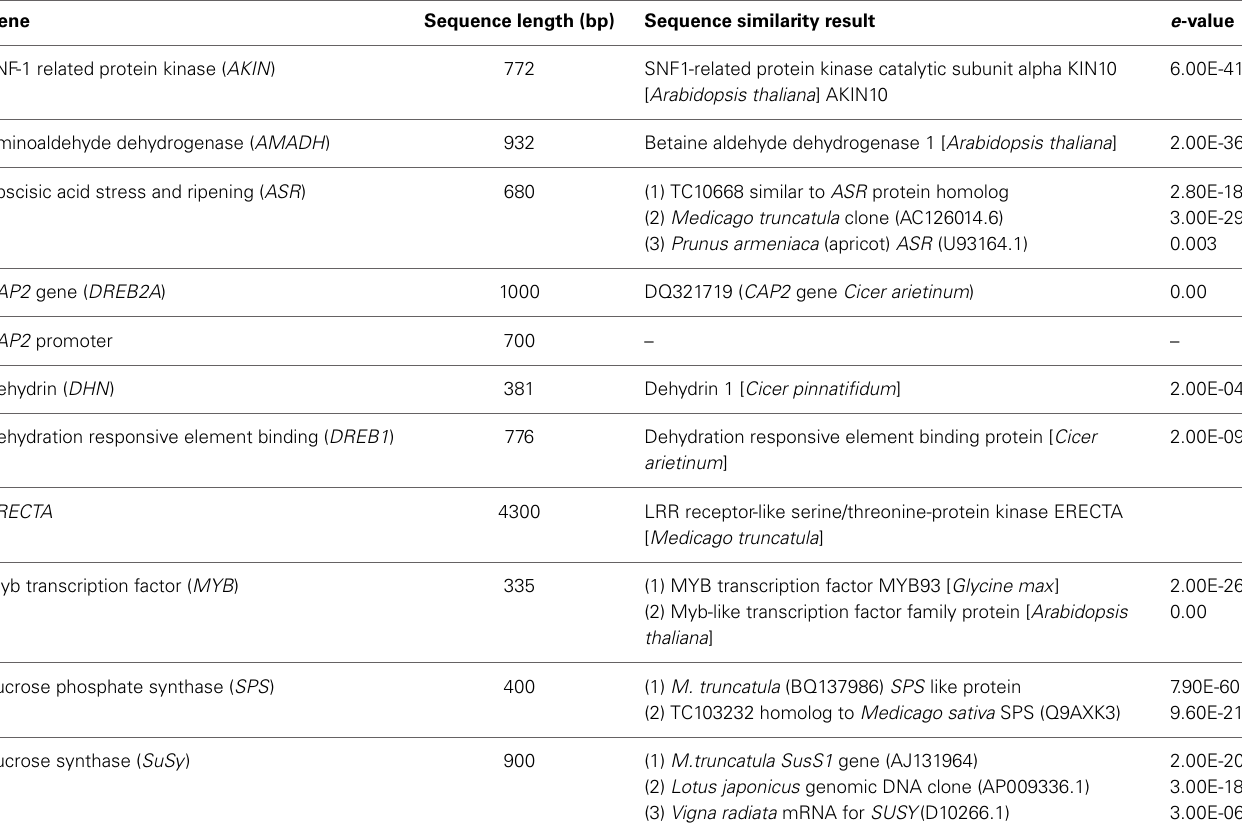
Table 2 | Summary of abiotic stress responsive candidate genes showing match with previously reported accession/gene in other crop species. Gene